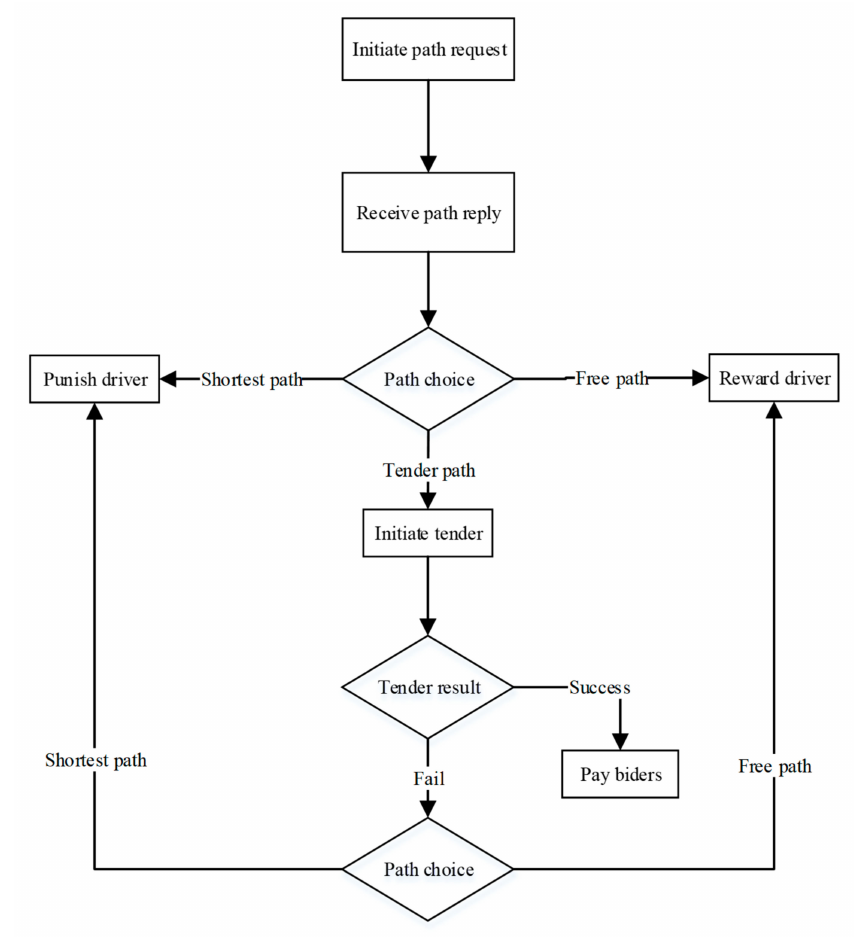
Figure 3. The process of choosing a